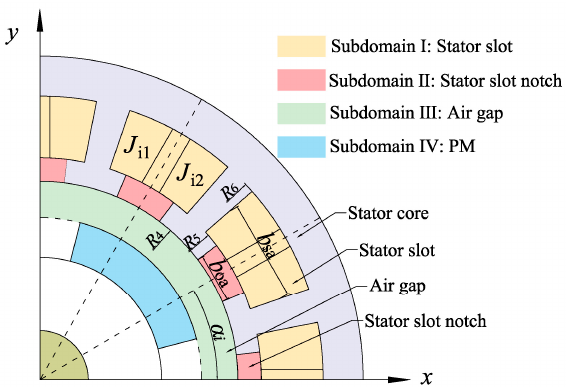
Figure 3. The equivalent diagram.